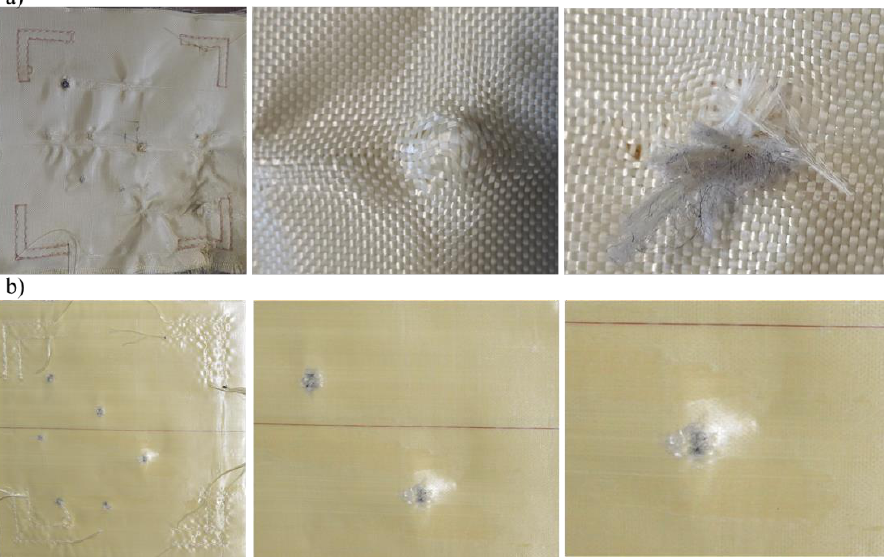
Figure 2. Soft ballistic inserts after FSP.22 fragment resistance tests: made from Twaron ® CT612 ( a ) and Twaron ® UD42 ( b